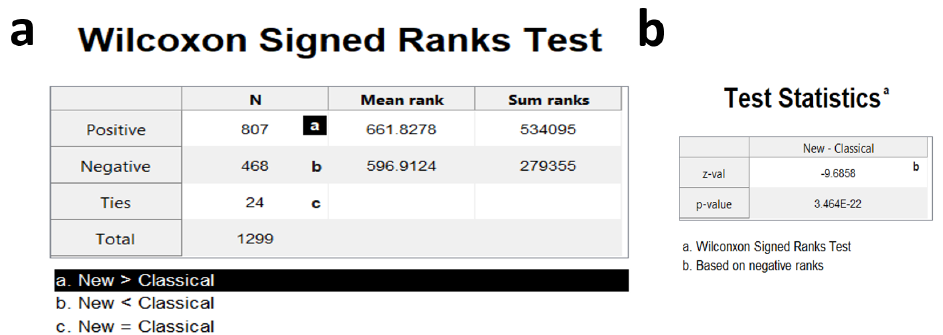
Figure A6. Wilcoxon signed rank test. ( a ) The Wilcoxon signed rank test table shows the difference that exists in two related samples through positive, negative and tie ranges. ( b ) p -value obtained with Wilcoxon rank test was 3.46E-22 less than the significance value of 0.05, so it was concluded that there was a statistically significant difference between both